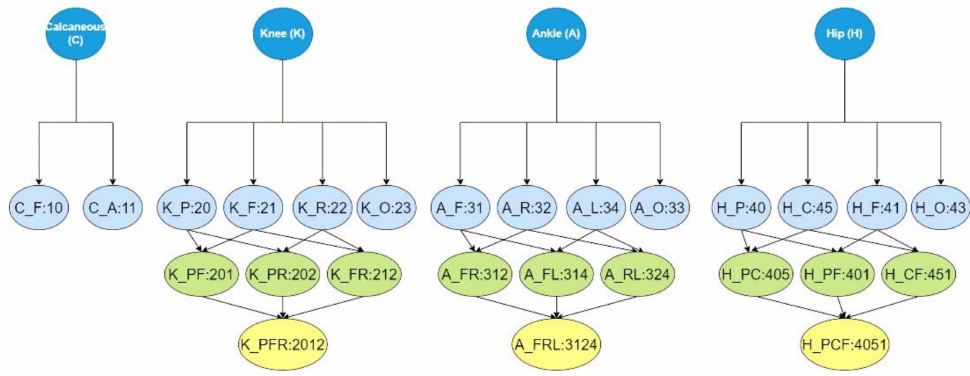
Figure 3. Class level Key-value